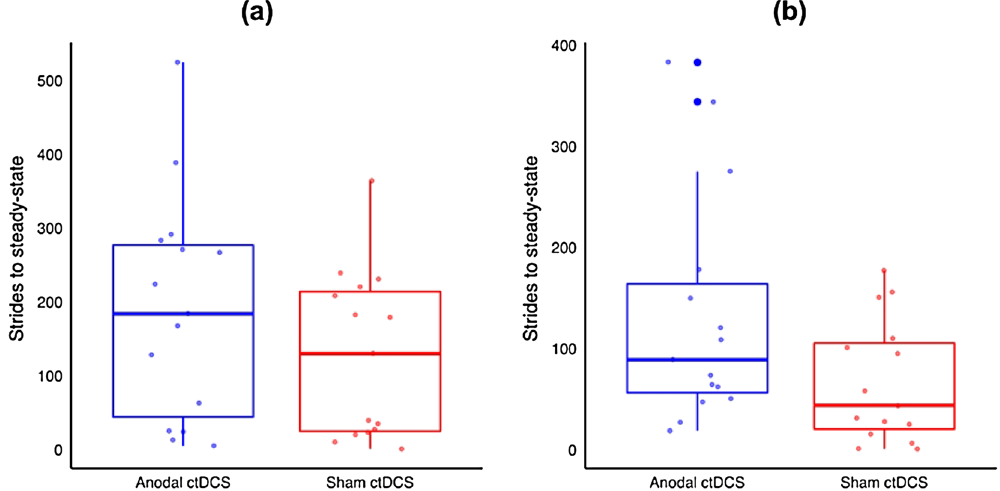
Figure 8. Box and scatter plots for strides to steady-state for ( a ) adaptation and ( b ) de-adaptation phases from the follow-up sessions. The thick horizontal lines represent the median, the hinges of the box plots represent 1st and the 3rd quartile, the whiskers are plotted at a distance of 1.5 times the inter-quartile range, the thick dots represent outliers and the thin dots represent the raw data from individual